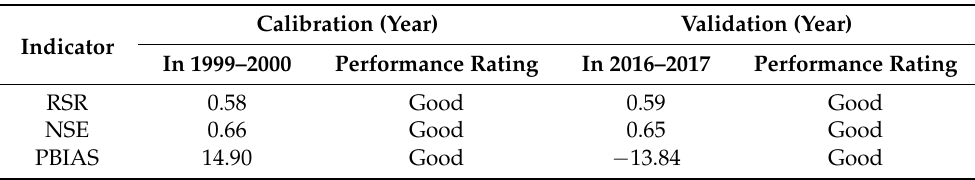
Note: Model performance rating scale by Moriasi et al.